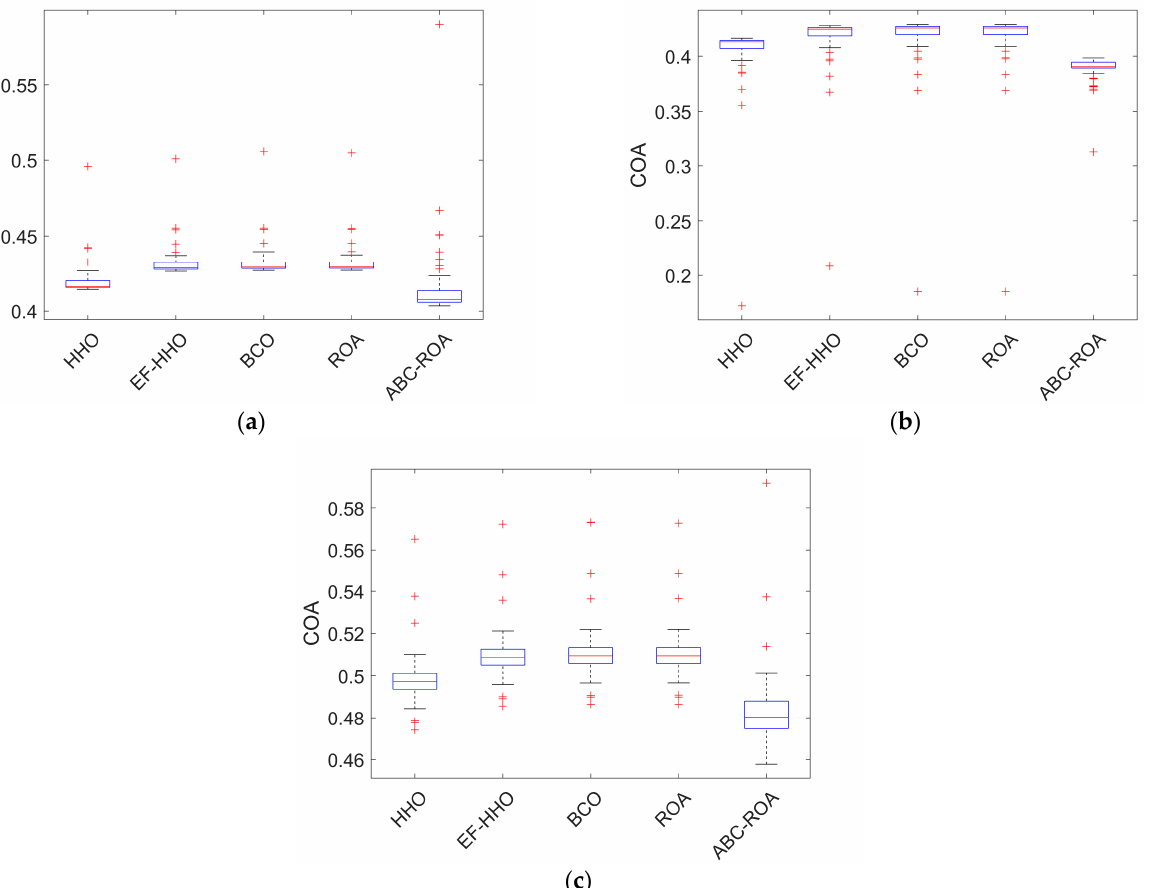
Figure 15. Performance analysis of the developed ABC-ROA based privacy preservation model us- ing COA regarding ( a ) dataset 1, ( b ) dataset 2, and ( c ) dataset 3.